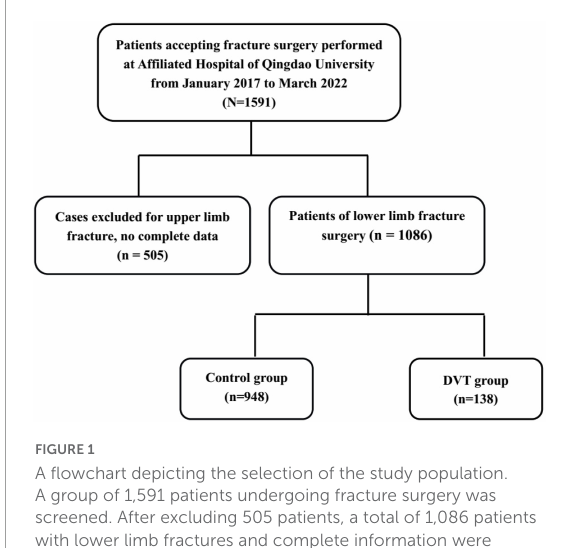
FIGURE1 A flowchart depicting the selection of the study population. A group of 1,591 patients undergoing fracture surgery was screened. After excluding 505 patients, a total of 1,086 patients with lower limb fractures and complete information were included, comprising 138 patients suffering from DVT and 948 controls.